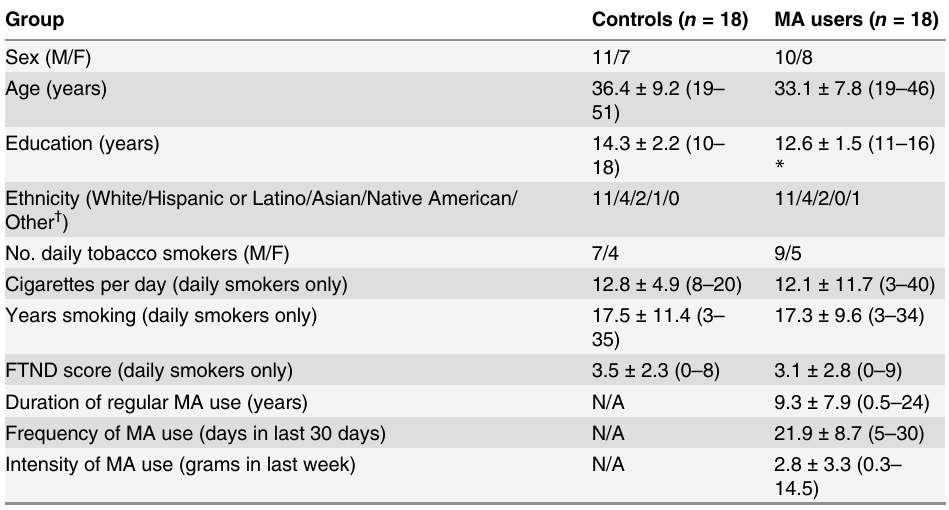
Table 1. Characteristics of research